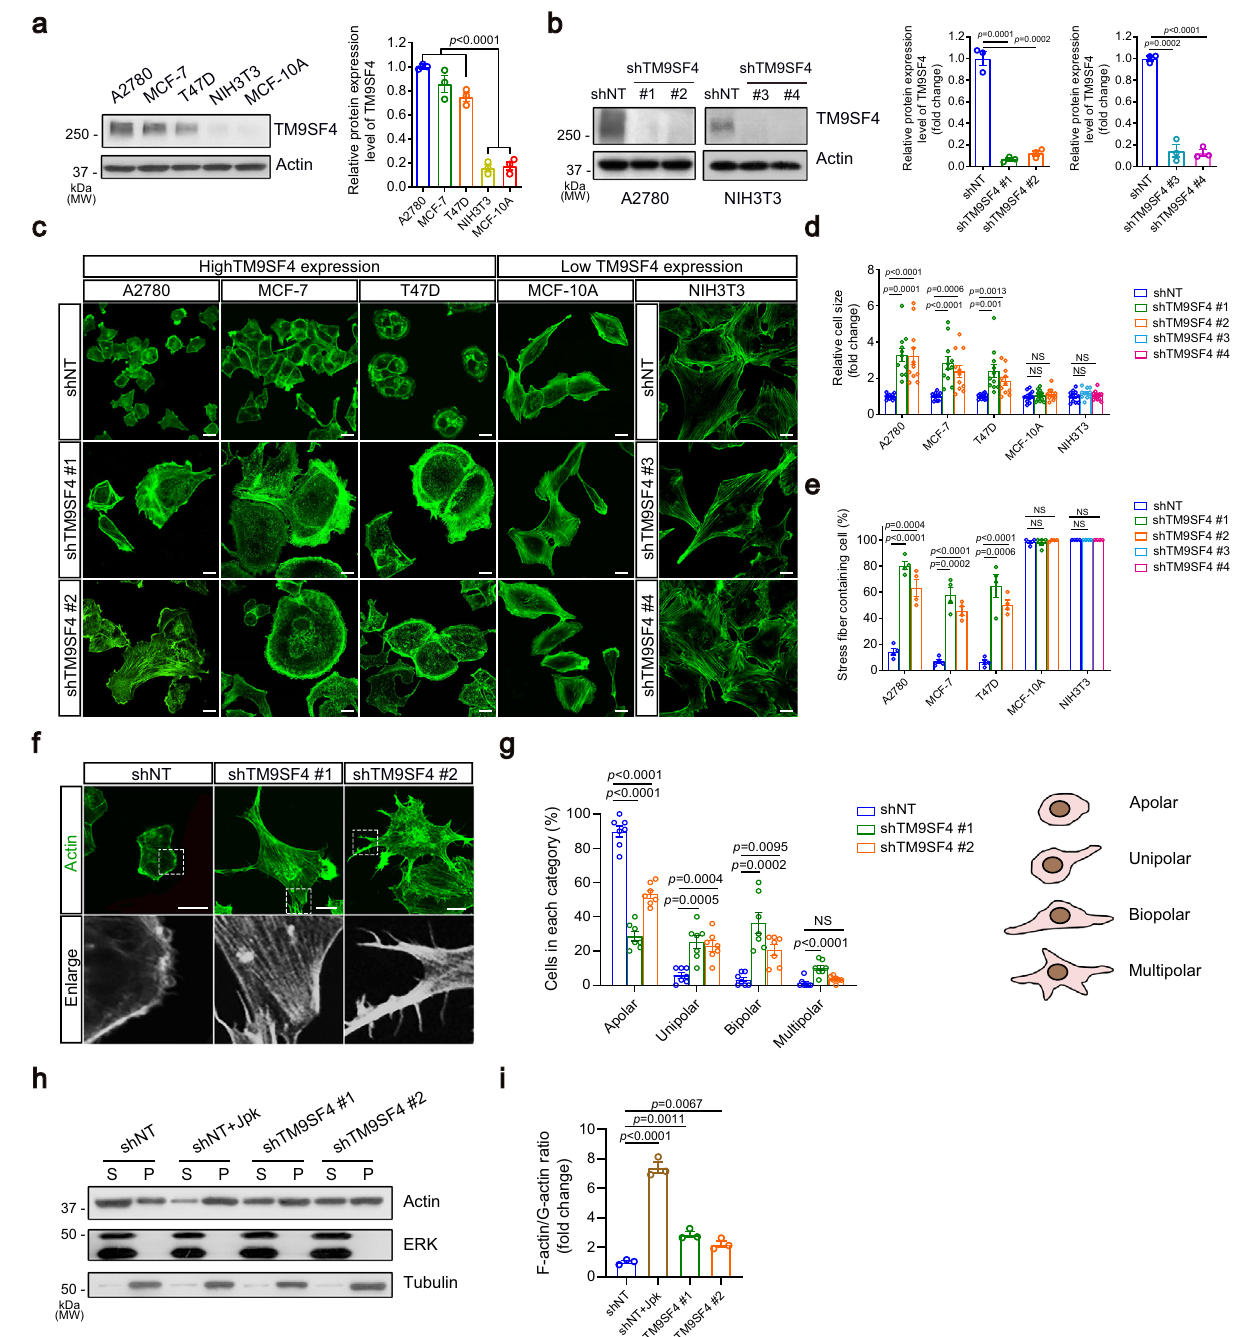
Fig. 1 | Knockdown of TM9SF4 increases the cell size and promotes F-actin formation in cancer cells. a , b Endogenous expression level of TM9SF4 in dif- ferent cell types ( a ) and knockdown ef fi ciency of TM9SF4-shRNAs ( b ). Shown are representative immunoblot images (left) and summary data (right) of TM9SF4 protein level ( n =3 biologically independent experiments). c – e TM9SF4 knock- down by lenti-shRNAs increased the cell size and F-actin stress fi ber formation in A2780cells, MCF-7cellsand T47Dcells,butnotinNIH3T3cellsandMCF-10Acells. Shown are representative confocal microscope images after FITC-phalloidin staining ( c ) and summary data ( d , e ). In e , the percentage of cells containing thick actin stress fi ber with a diameter >0.5 μ m was analyzed ( n =4 biologically inde- pendentexperiments,>200cellsfromthree different fi elds perexperiment).Scale